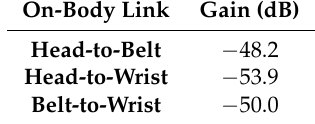
Table 1. Average gain for each on-body link. On-Body Link Gain (dB) Head-to-Belt − 48.2 Head-to-Wrist − 53.9 − 50.0